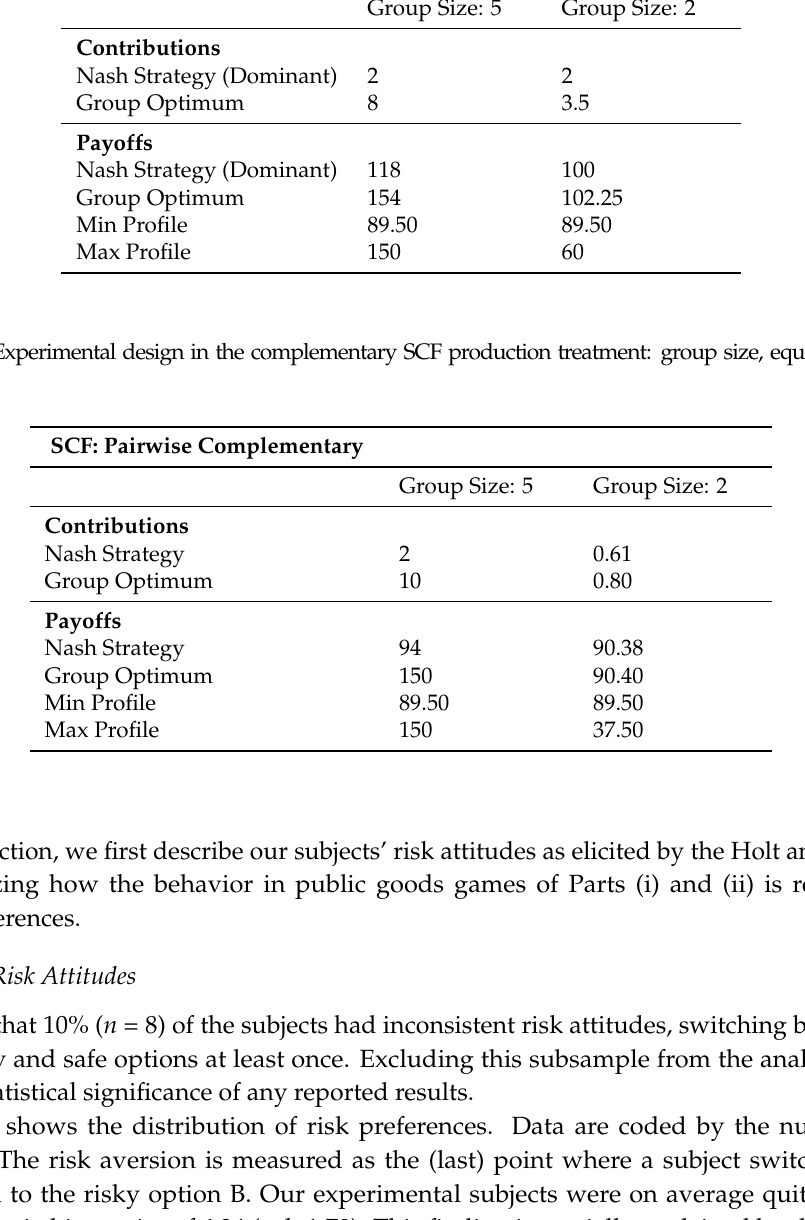
Table 4. Experimental design in the linear SCF production treatment: group size, equilibria and payoffs. SCF: Standard Linear Group Size: 5 Group Size: 2